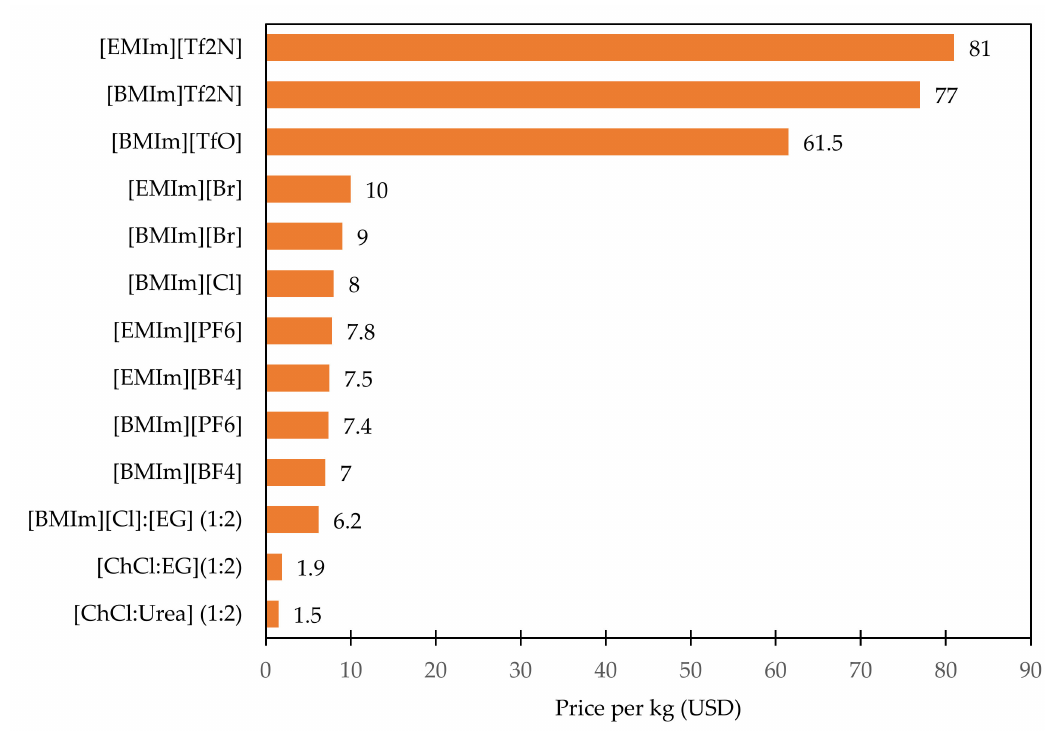
Figure 7. Plot comparing the cost of the ILs, DESs in USD per kg that are computed based on the raw materials cost by adopting the methodology reported by